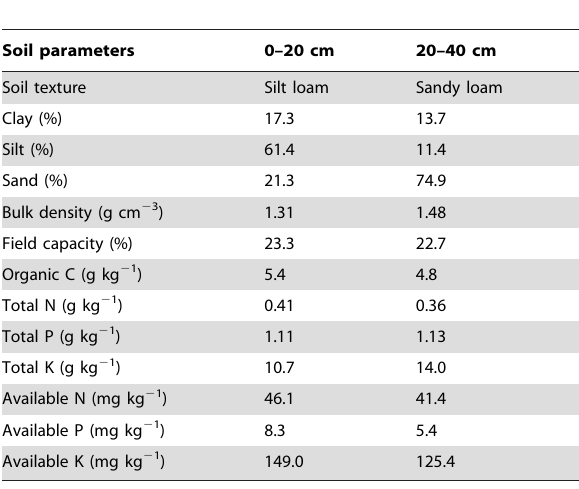
Table 1. Physical and chemical properties of soil at different layers at Yucheng, Shandong Province of China in 1990.